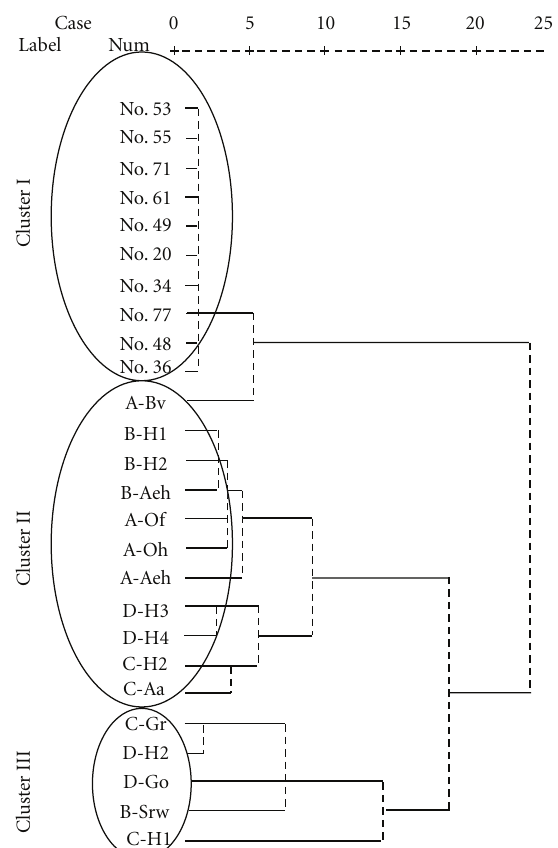
Figure 4: Dendrogram using average linkage (between groups) of Sulfur K-edge XANES spectrum of typical marine sediments (TMS), tsunami backwash deposits (TBD), and German terrestrial soils (GS).